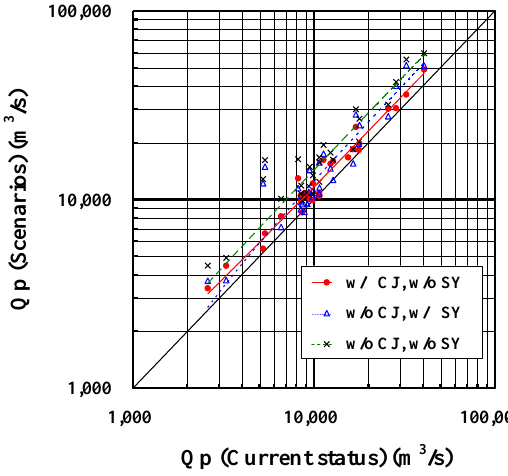
Figure 14. Annual Maximum Series according to the Scenarios (Hourly).